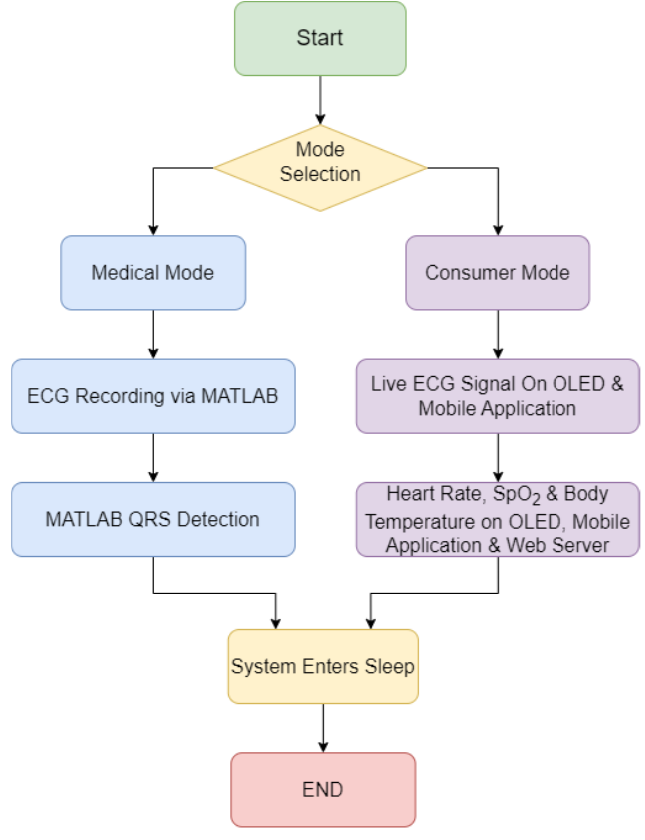
Figure 3. System flow diagram.